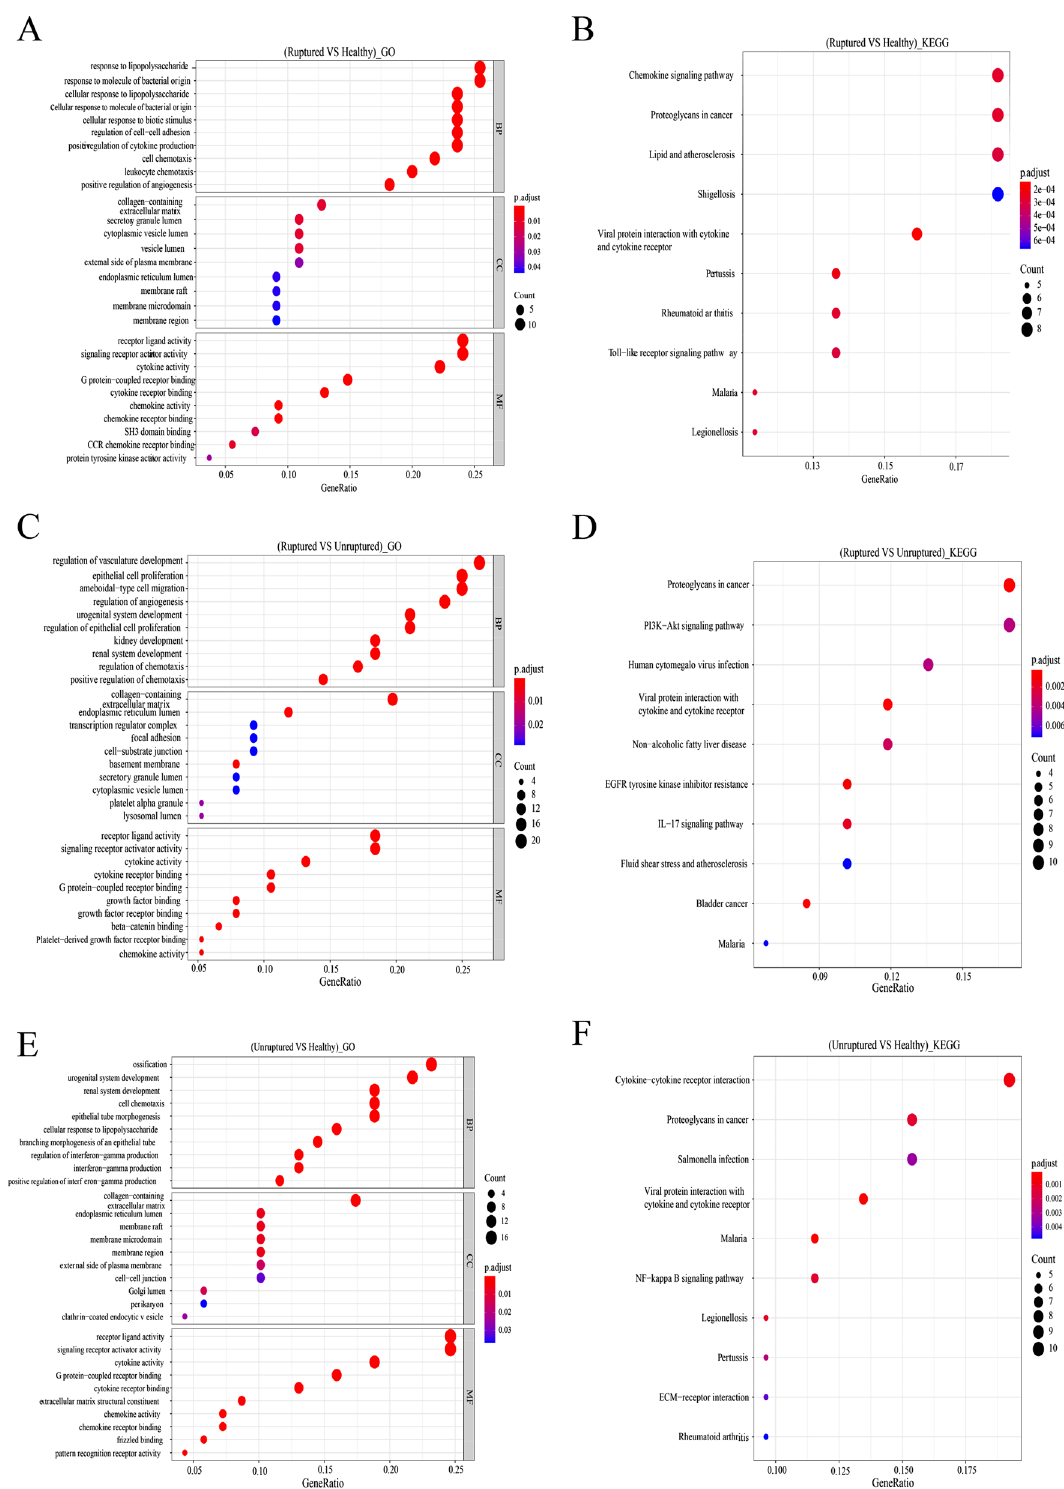
Figure 2. Enrichment and pathway analyses of various DEGs. ( A, B ) Gene Ontology (GO) and Kyoto Encyclopedia of Genes and Genomes (KEGG) analyses of DEGs (ruptured vs. healthy). ( B, C ) GO and KEGG analyses of DEGs (Ruptured vs. Unruptured). ( D, E ) GO and KEGG analyses of DEGs (unruptured vs. healthy). BP (biological process), CC (cellular component), MF (molecular function).above all figures were visualized by R software